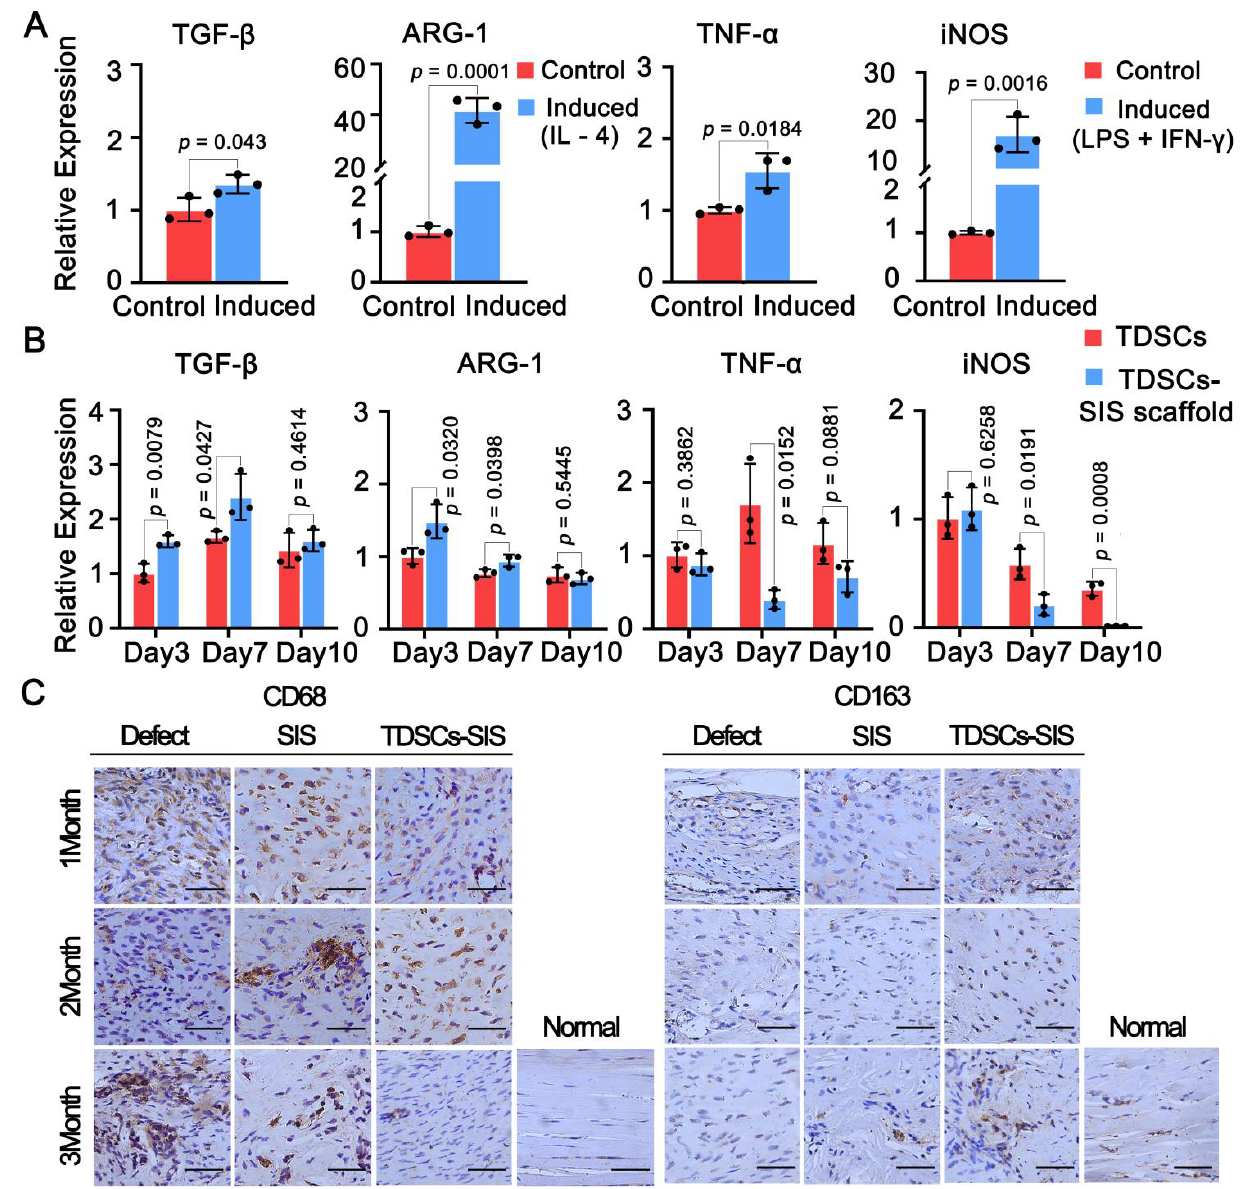
Figure 7. TDSCs–SIS scaffold facilitated macrophage polarization toward the M2 phenotype. ( A ) LPS and IFN- γ or IL-4 were used to construct the model of M1 and M2 polarization in RAW264.7 cells. ( B ) The expression effect of TGF- β and ARG-1 in TDSCS–SIS scaffold group was better than